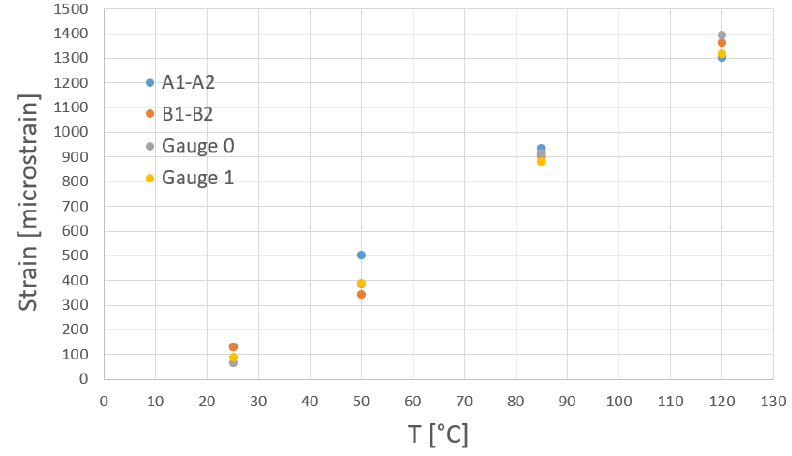
Figure 8. Comparison between maximum values of maximum principal strain: DIC vs. strain gauge measurement.